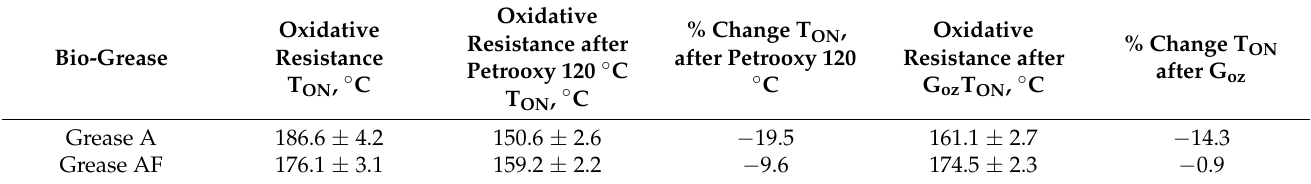
Figure 6. The change of resistance to oxidation after thermo-oxidation and mechanical forces for: ( a ) vegetable grease A, ( b ) vegetable–mineral grease AF.